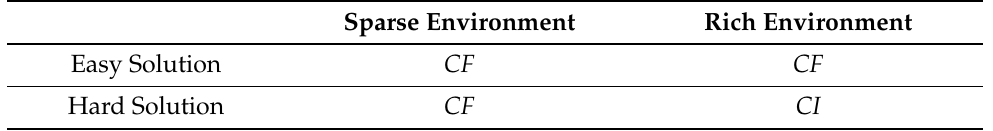
Table 1. Computational feasibility in sparse and rich environments. CF = Computationally Feasible, CI = Computationally